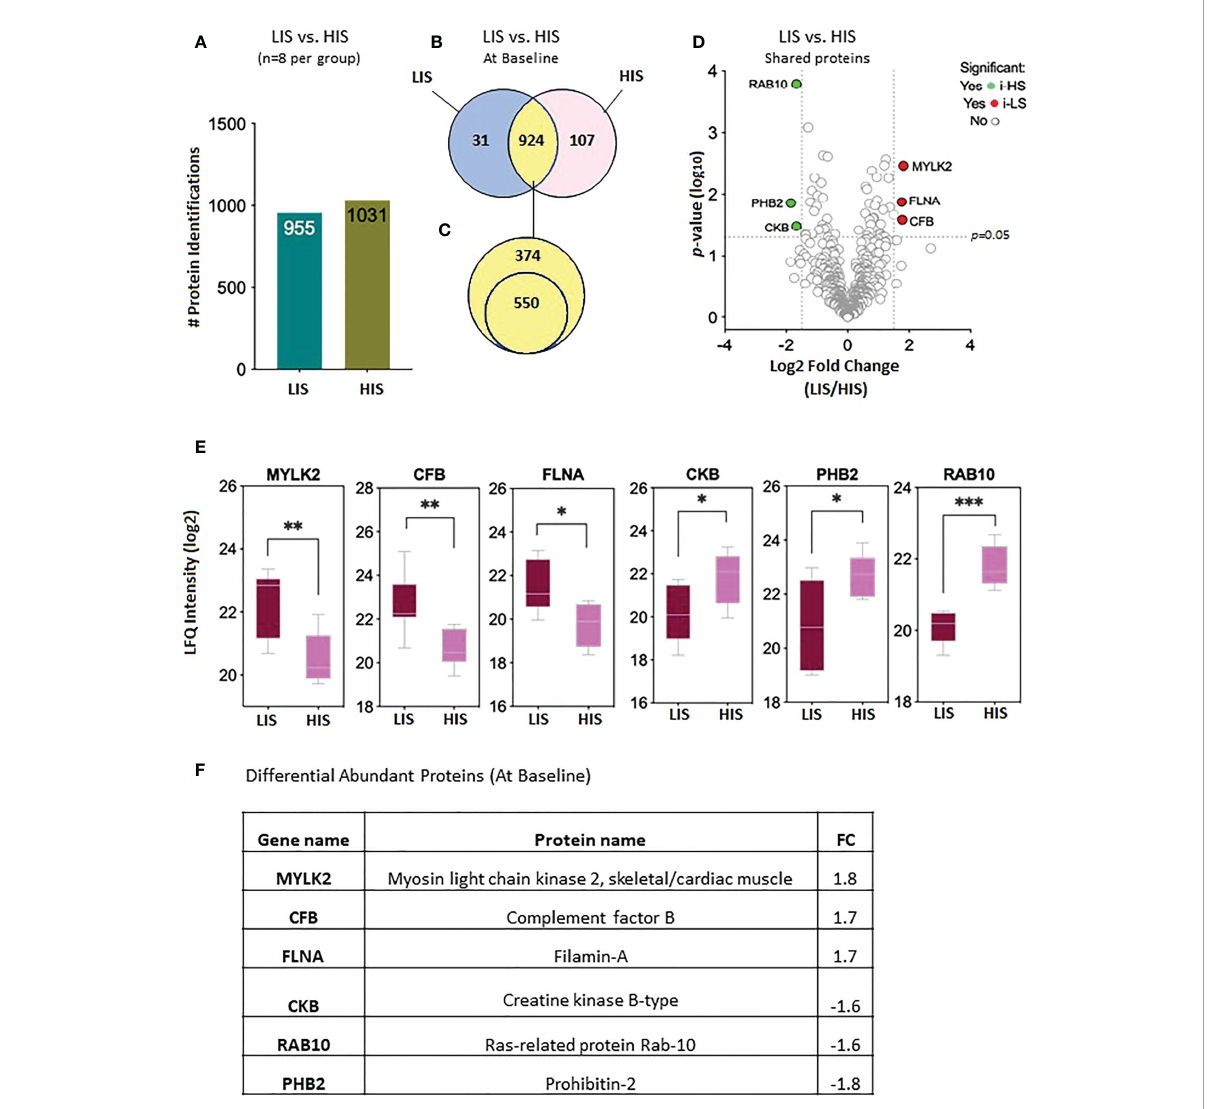
FIGURE 3 Baseline protein levels in the subjects with low insulin sensitivity (LIS) versus the subjects with high insulin sensitivity (HIS). (A) Bar chart representing the number of proteins identi fi ed in each group. (B) Venn diagram showing the unique and common proteins in LIS and HIS. (C) Proteins sorted for presence in at least 50% of the subjects. (D) . Volcano plot showing the differential abundance of proteins present in both the groups. (E) Box plots representing the proteins with signi fi cant differential abundance. *p=0.02, **p=0.002, *** p=0.0003. (F) Fold changes in the proteins showing statistically signi fi cant differential abundance in LIS versus HIS at